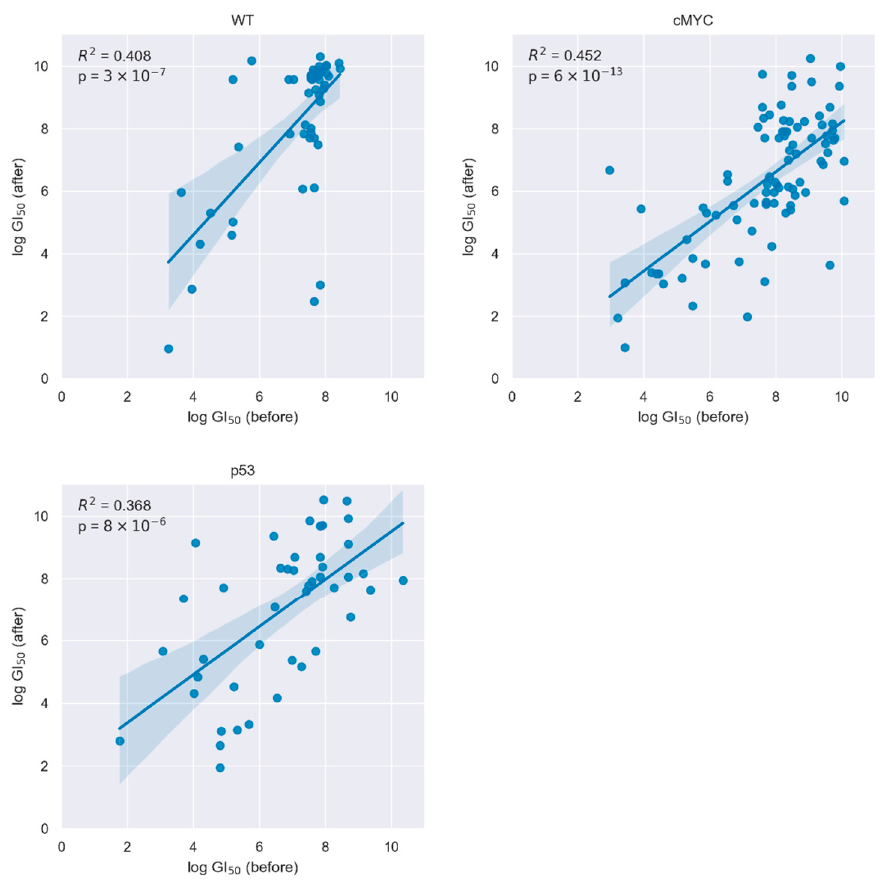
Figure 1. The relative drug response of the top 20 drugs stayed similar upon cryopreservation. Scatterplots showing the linear regression between GI50 log concentration of the 20 most responsive drugs prior to cryopreservation and the corresponding drug response after cryopreservation. Table 1. The list of stable and unstable drugs for IPS11-wild type.